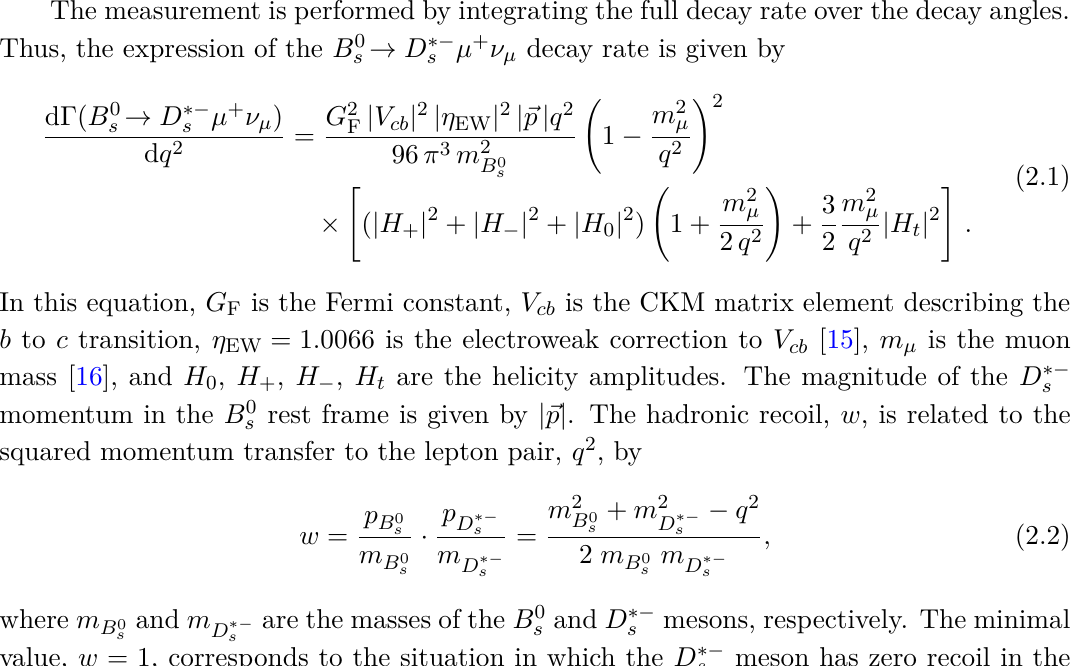
→ D ∗− µ + ν µ decay, introducing the angles θ D s s